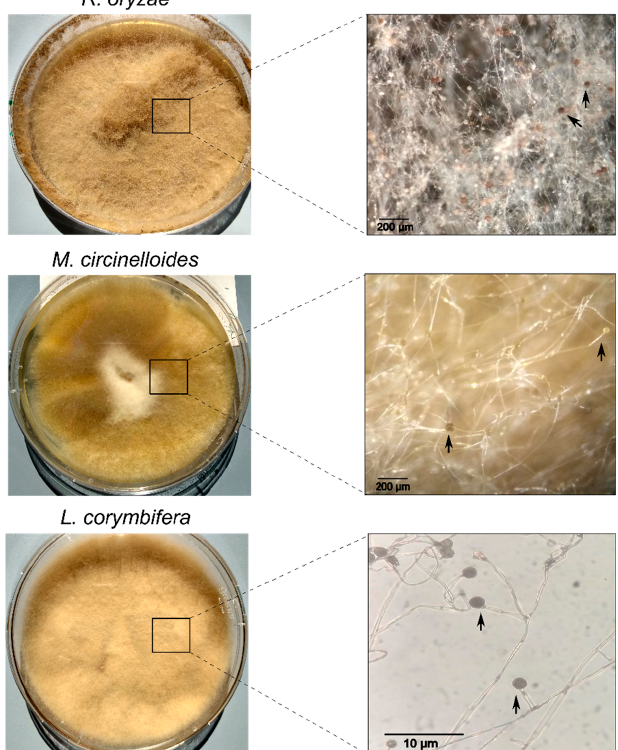
Figure 1. The most common pathogenic mucoralean fungi. Rhizopus oryzae (syn.: Rhizopus arrhizus ), Mucor circinelloides , and Lichtheimia corymbifera are the most frequently reported causative agents of mucormycosis. The left panel depicts the colony morphologies of four-week-old R. oryzae and L. corymbifera cultivated on malt extract agar, as well as the colony morphology of one-week-old M. circinelloides cultivated on potato dextrose agar. The right panel represents the corresponding micromorphologies including sporangia (marked with arrows), in which the sporangiospores are produced. Sporangium of R. oryzae presents a dark-brown coloration, while M. circinelloides exhibits a yellow color and L. corymbifera a dark grey